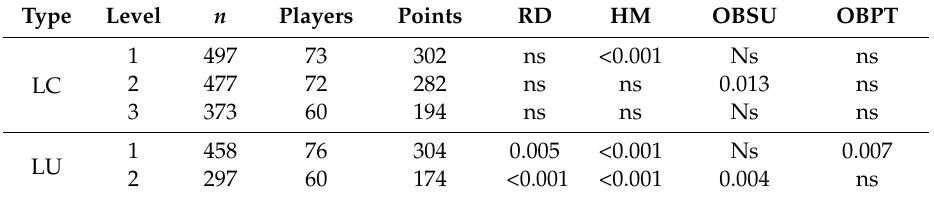
Table 9. Models tested for agreement (yes/no) between FotoQuest Austria and LUCAS 2015 land cover (LC) and land use (LU). p -values are shown when appropriate. Number of observations ( n ) is shown. ns = not significant.